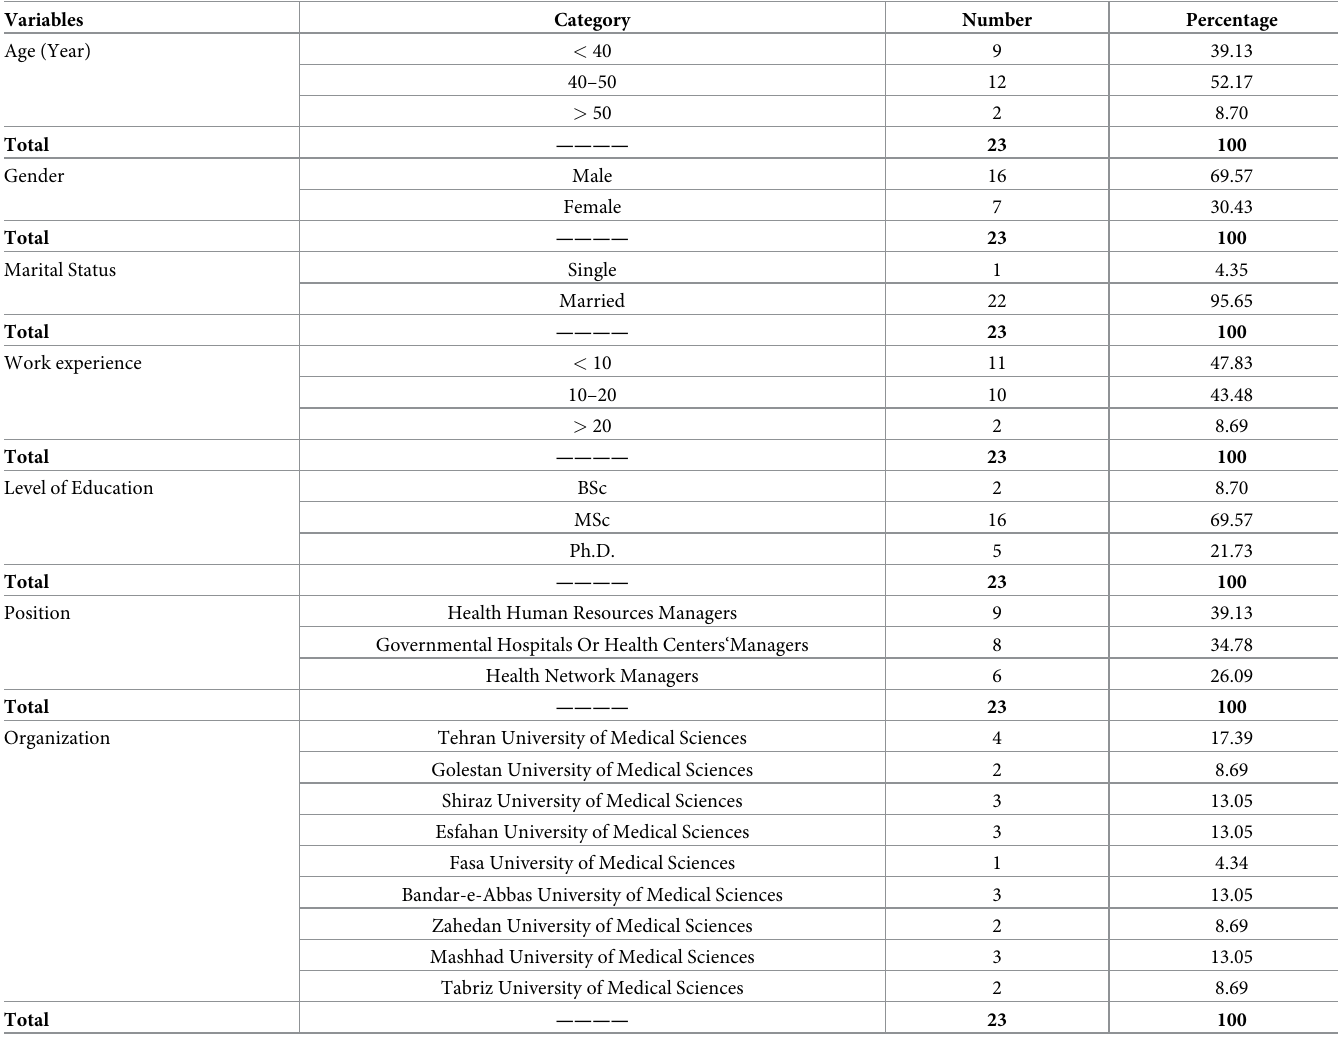
Table 1. Frequency distribution of the study